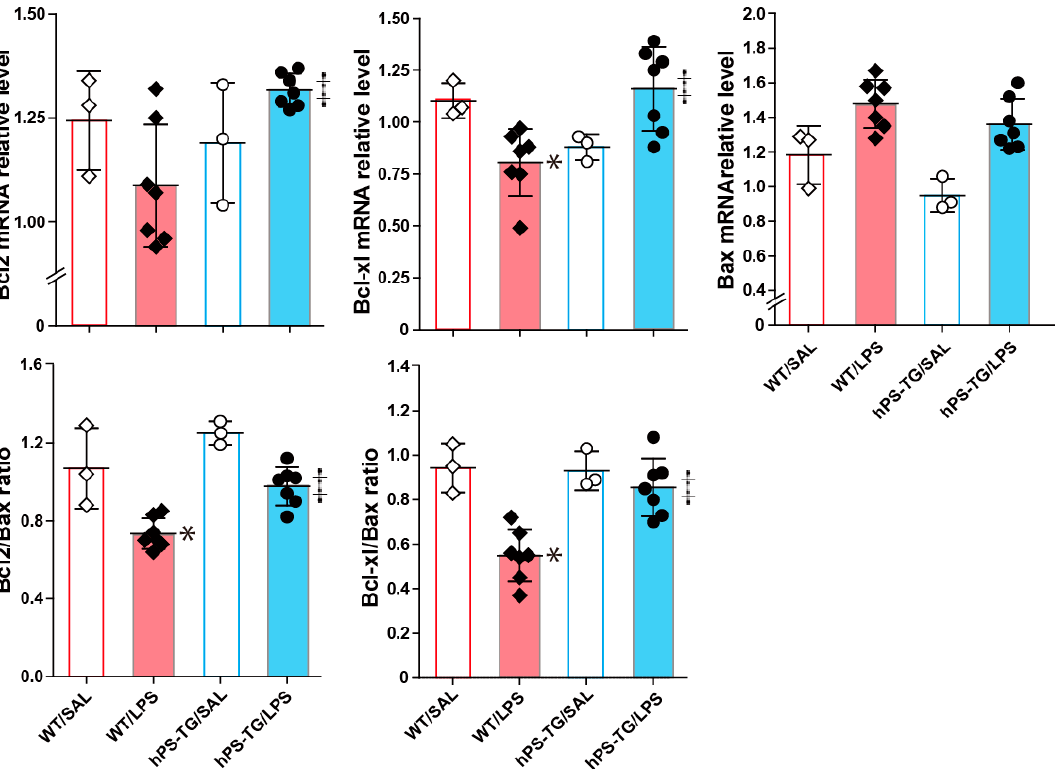
Figure 6. Regulation of the expression of apoptotic factors by hPS. Mice were allocated in four groups including wild-type mice treated with saline (WT/SAL, n = 3) or LPS (WT/LPS, n = 7), and human PS transgenic (TG) mice treated with saline (hPS TG/SAL, n = 3) or LPS (hPS TG/LPS, n = 7). Total RNA was extracted from the whole lung tissue, reverse-transcribed and then PCR was performed using gene-specific primers. The mRNA expression of the anti-apoptotic factors Bcl2 and Bcl-xl and of the apro-apoptotic factor was evaluated by PCR. Data are expressed as the mean ± SD. * p < 0.05: WT/LPS vs WT/SAL; ‡ p < 0.05: hPS-TG/LPS vs WT/LPS.